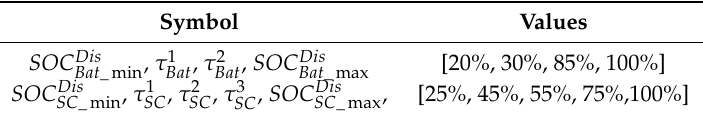
Figure 6. The SOC combination of batteries and supercapacitors under three load demands, and the operation zone L SC of supercapacitors is divided into eight cases. Table 2. The threshold values of the SOCs of batteries and